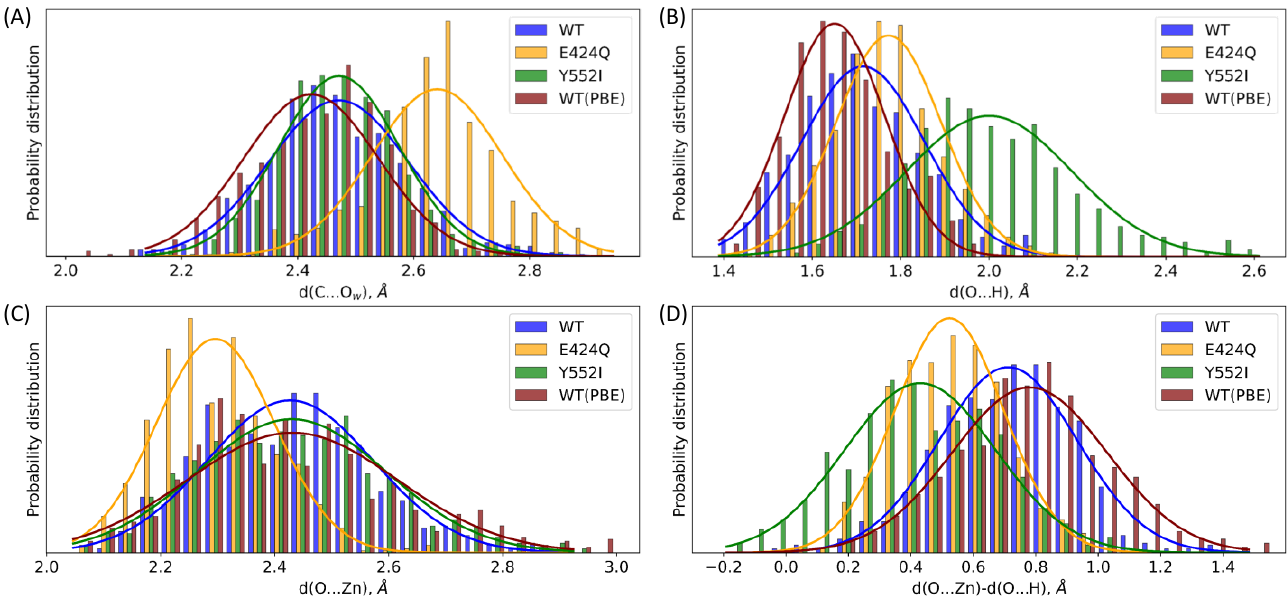
Figure 6. Distributions of distances in the QM/MM MD trajectories of the ES complexes of the wild type (WT, blue) GCPII and its E442Q (orange) and Y552I (green) mutants calculated with the PBE0 functional. Distributions obtained for the WT enzyme computed with the PBE functional are shown in maroon. ( A ) The distance of the nucleophilic attack is (d(C…O w ); ( B ) hydrogen bond between the oxygen atom of the carbonyl group of the substrate and hydrogen atom of the side chain of Tyr552 (replaced by an auxiliary water molecule in Y552I), d(O…H); ( C ) coordination bond between the oxygen atom of the carbonyl group of the substrate and zinc cation, d(O…Zn); ( D ) difference of d(O…Zn) and d(O…H).